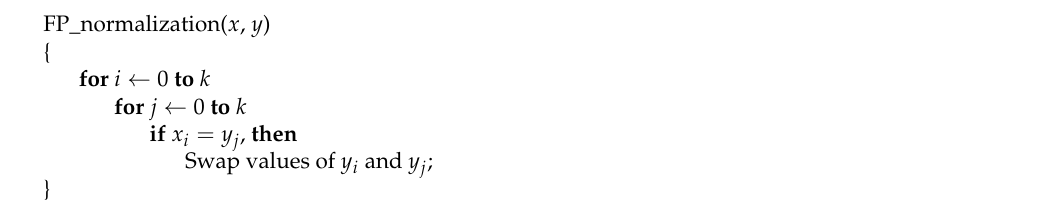
Figure 3. Pseudocode of normalization to preserve feasibility.